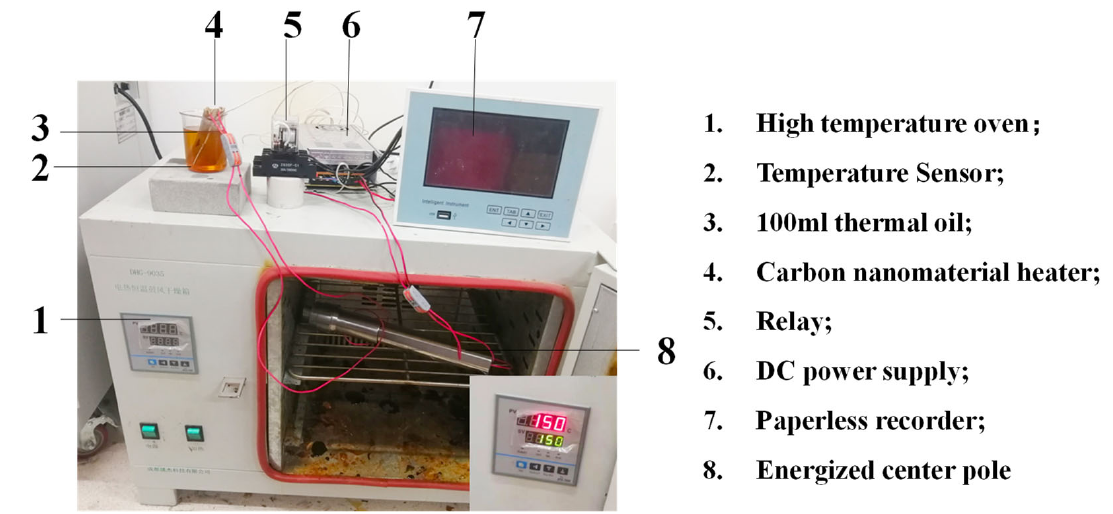
Figure 26. The physical experiment platform.